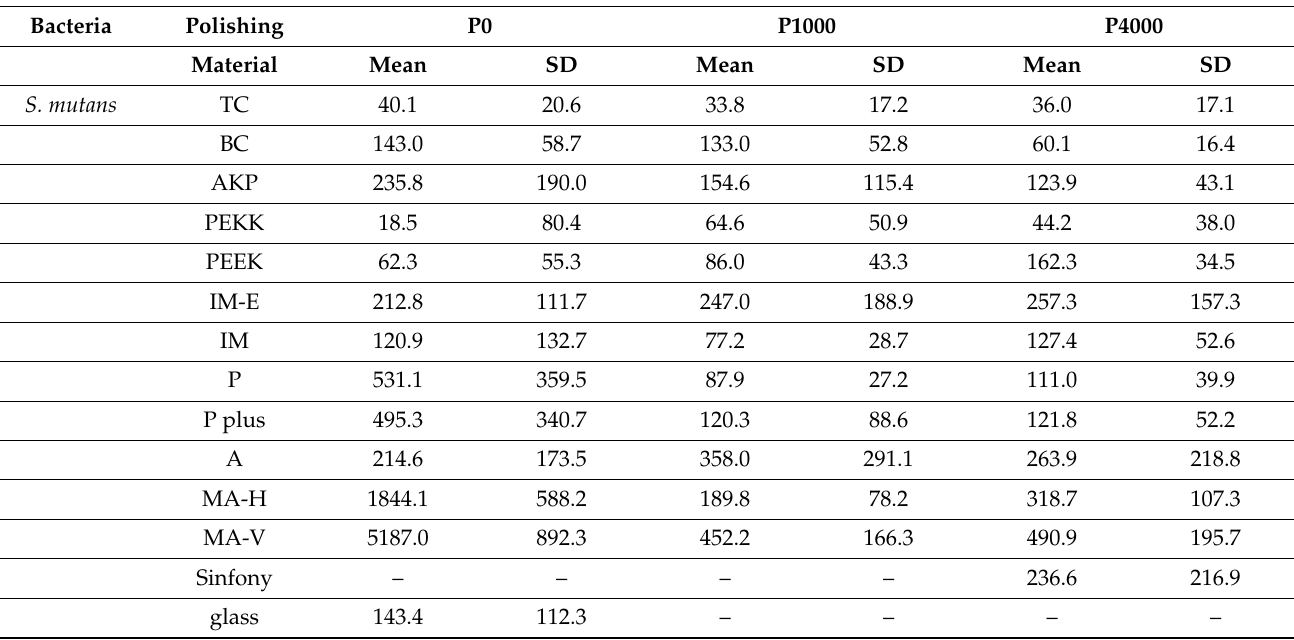
Table 2. Relative fluorescence intensities (mean and standard deviation; –: not determined) with bacteria ( S. mutans and S. sanguinis ) on different materials with different surface treatments (P0, P1000, and